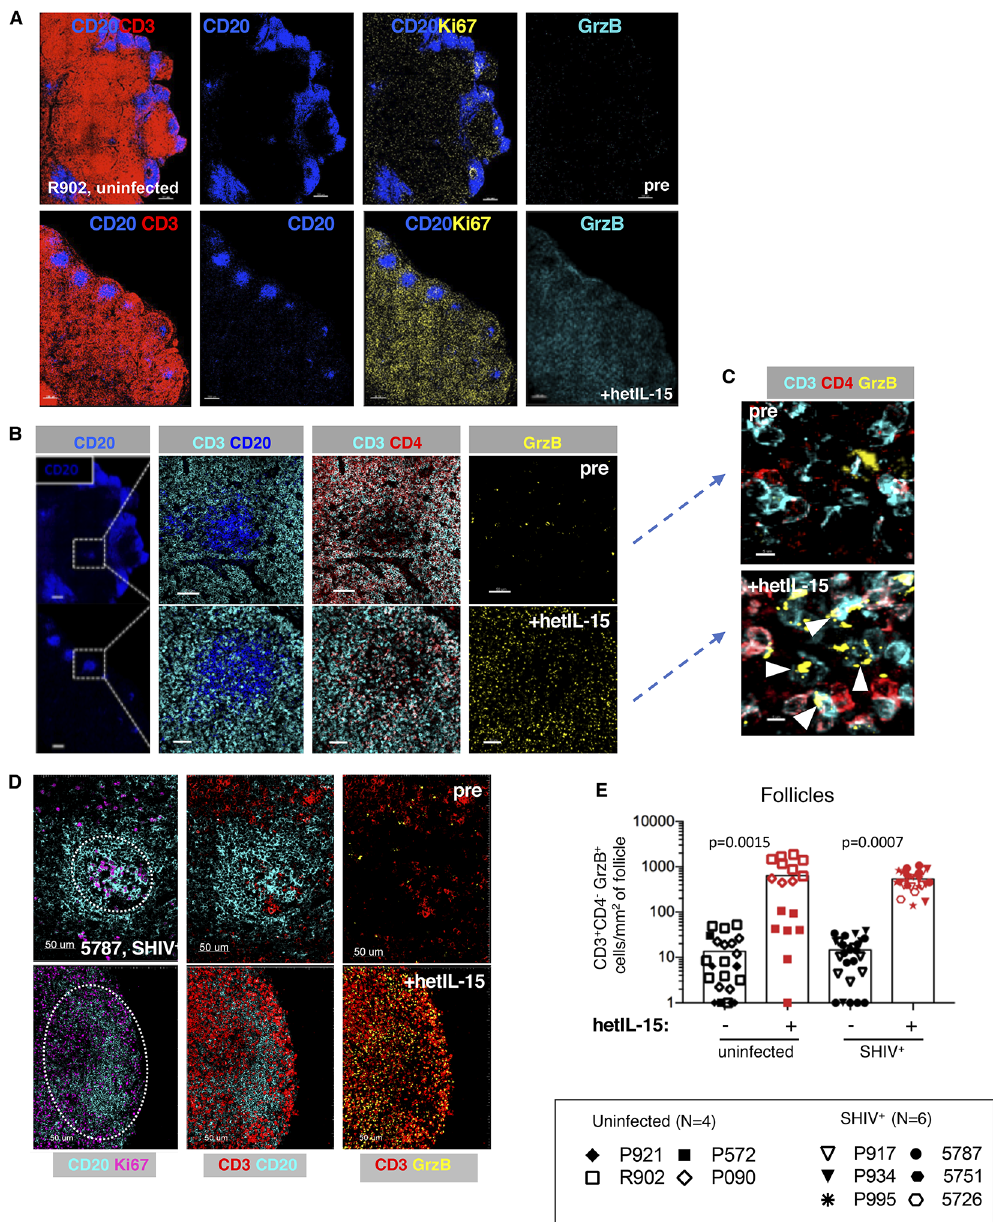
Fig 4. Accumulation of Ki67 + and GrzB + CD8 + T cells in follicular areas upon hetIL-15 treatment. (A) Representative confocal images showing the distribution of CD20 (blue), CD3 (red), Ki67 (yellow) and GrzB (cyan) positive cells in peripheral LN from an uninfected macaque (R902) before and after hetIL-15 treatment. Pre-treatment is shown in the upper panels and +hetIL-15 in lower panels throughout. Follicles are defined as CD20 hi-dim areas. (B) Higher magnifications from the same LN in panel A of areas indicated by squares. CD20 (blue), CD3 (cyan), CD4 (red) and GrzB (yellow). Follicular areas defined by CD20 (left panel) show increased presence of CD8 + cells (defined as CD3 + CD4 - ) (middle panel) and GrzB + cells (right panel) upon hetIL-15 treatment. (C) Higher magnification (from panel B) shows presence of CD3 + CD4 - GrzB + (GrzB + CD8 + ) cells upon hetIL-15 treatment (white arrowheads). (D) Confocal images showing the distribution of CD20 (blue), Ki67 (purple), CD3 (red) and GrzB (yellow) positive cells in a representative follicle. Pre (upper panels) and +hetIL-15 (lower panels) from an SHIV + macaque (5787). (E) Individual follicles were analyzed upon hetIL-15 treatment in LN from 4 uninfected (3 animals pre and +hetIl-15; one animal +hetIL-15) and 6 SHIV + macaques (3 animals pre and +hetIl-15; 3 animals +hetIl-15). A range of 2 to 14 follicles were analyzed per animal. The numbers of CD3 + CD4 - GrzB + cells per mm 2 of area are in individual follicles for each animal are shown. Values of 0 were entered as 1 for the graph display only. Bars indicate average values. p values are calculated by two-way ANOVA for the SHIV + versus uninfected and pre- versus post- hetIL-15 effects, with random effects to account for the clustered values by